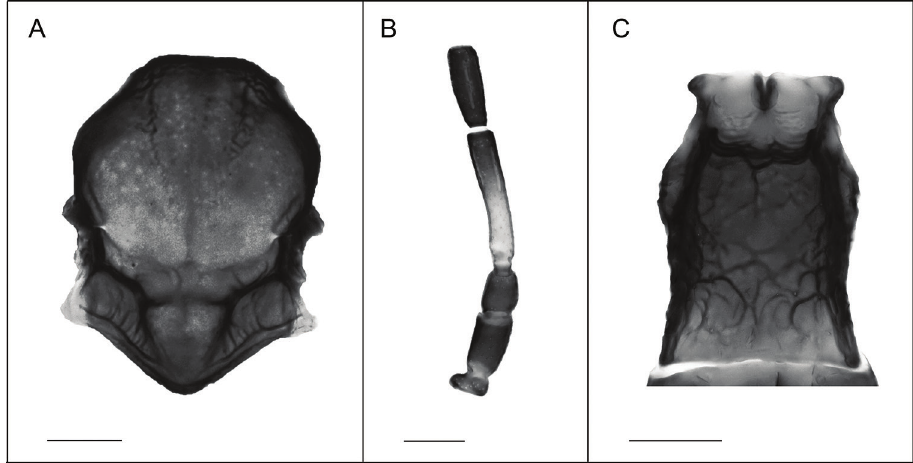
Figure 3. Ephedrus validus A mesoscutum – dorsal aspect B first and second flagellar segments C petiole – dorsal aspect. Scale bars: 100